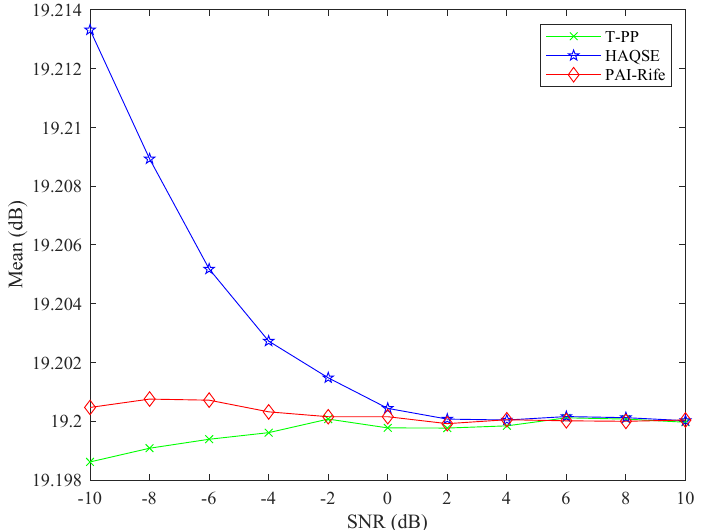
Figure 8. Mean of PAI − Rife and other frequency domain estimation algorithms at different SNRs.